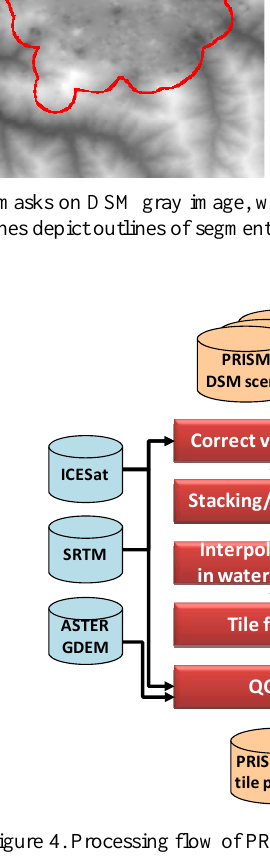
Figure 4. Processing flow of PRISM/DSM tile product